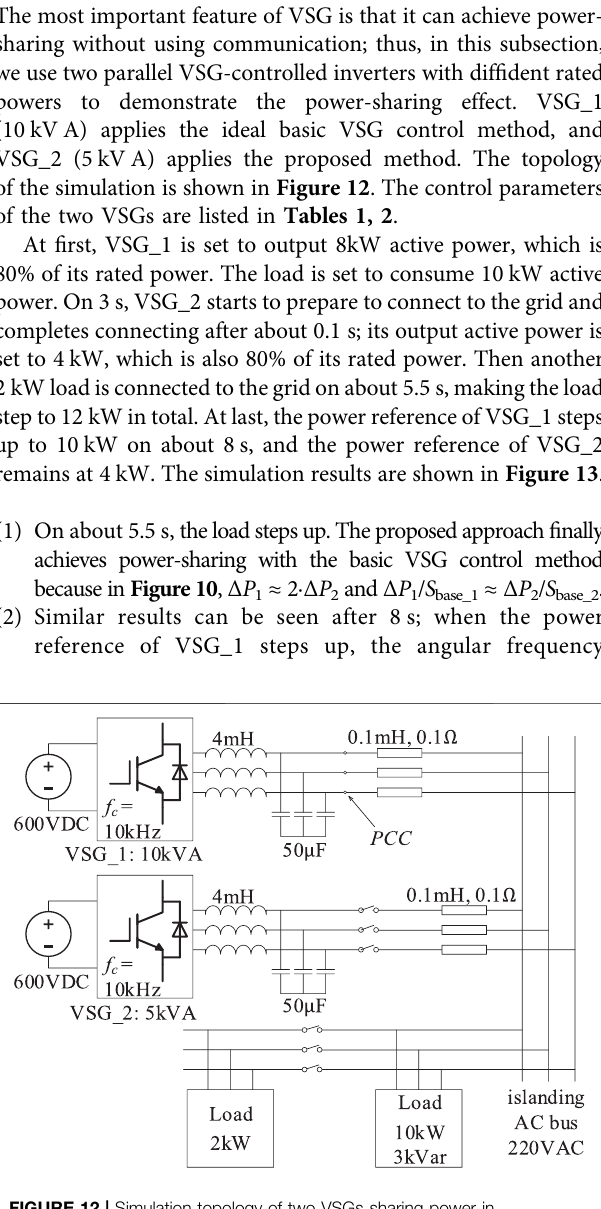
FIGURE 12 | Simulation topology of two VSGs sharing power in